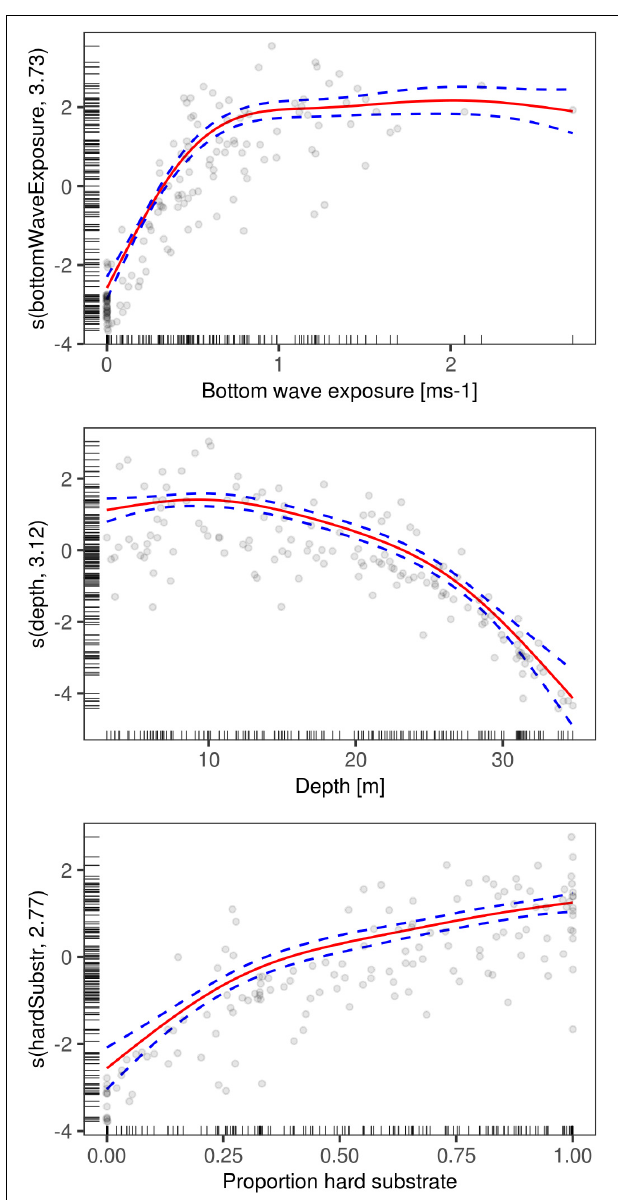
FIGURE 5 | GAM response curves of the biomass of Laminaria hyperborea for the model containing the predictors bottom wave exposure, depth, and proportion hard substrate. The y -axis indicates the relative influence of each predictor on the biomass. The fitted line is in red with blue lines representing 1 SE. Grey, hollow circles represent observation